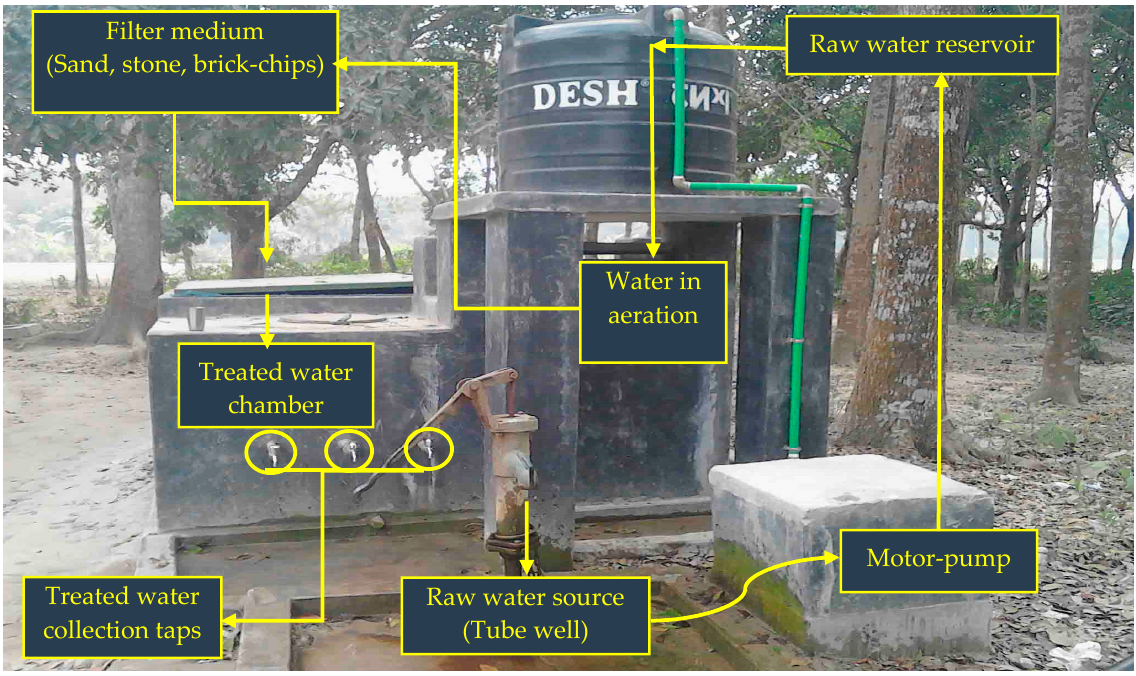
Figure 1. A schematic diagram of AIRP in the rural area of Jashore district in southwest Bangladesh.